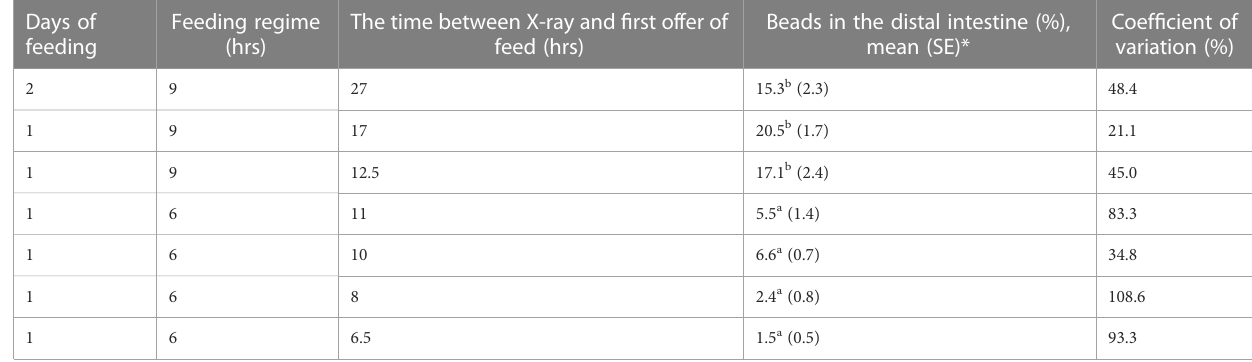
TABLE 3 The effect of the time of X-ray relative to the time of fi rst being offered feed and the length of feeding regime for receiving the entire daily ration of feed on the percentage of total beads in the distal intestine. Days of